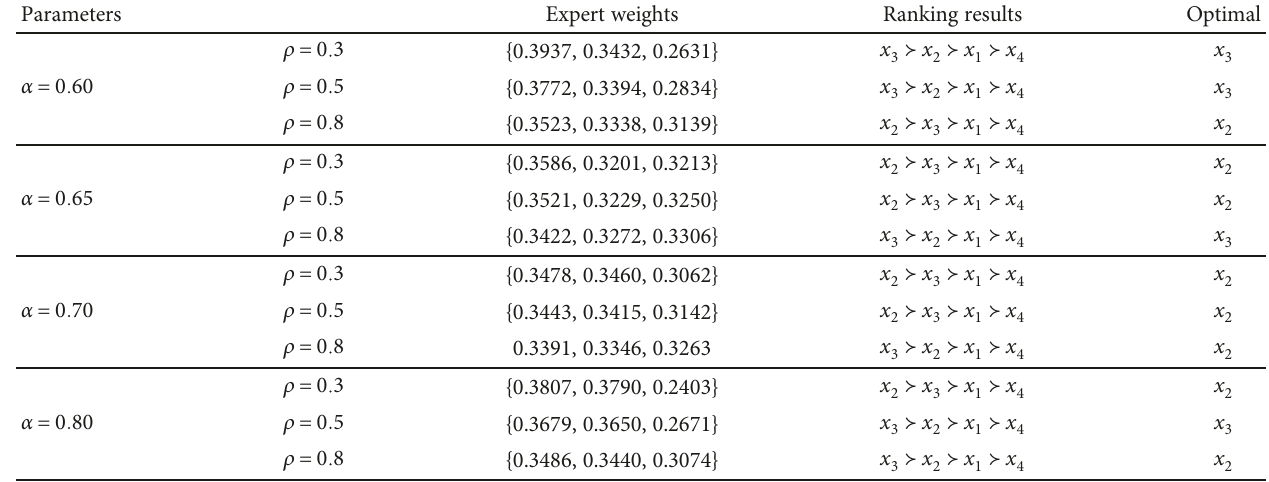
Table 15: Experts ’ weights and ranking results with di ff erent parameters α and ρ .